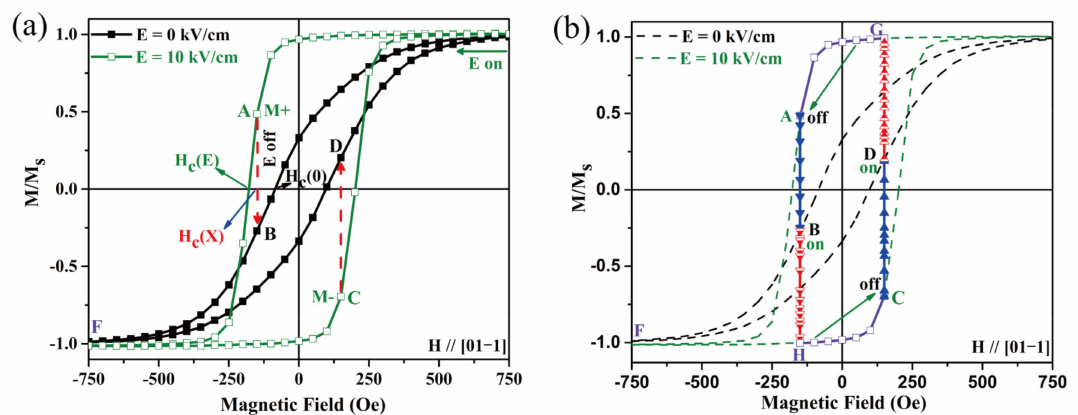
Figure 3. ( a ) The process of electric-field-manipulated magnetization vector switching by manipulating two magnetization states in the FePt/PMN-PT/Au; ( b ) the 180 ◦ magnetization reversal with a small bias magnetic field by alternating on or off electric field.